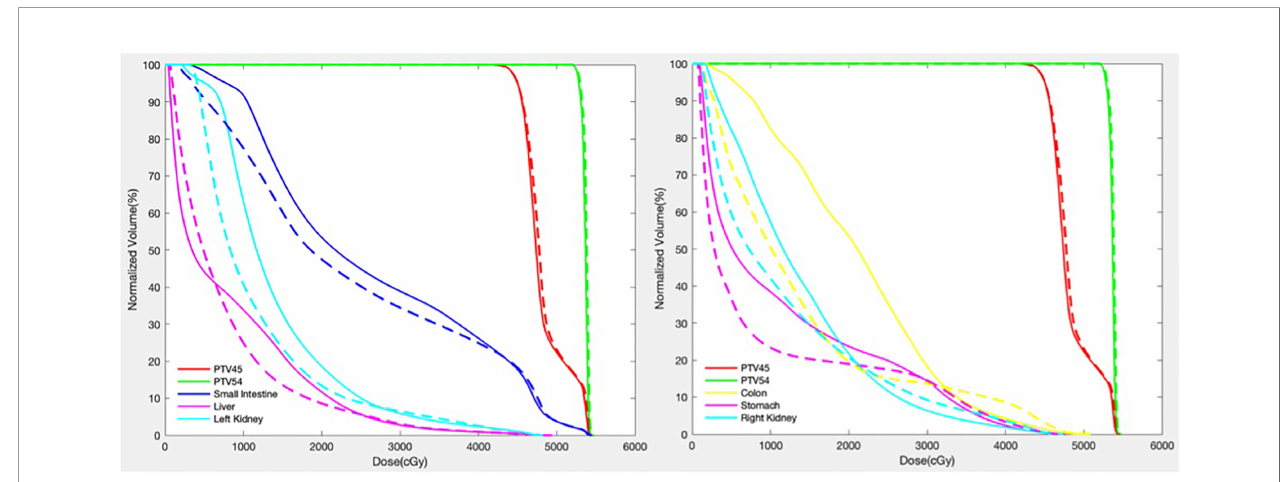
FIGURE 3 | Dose – volume histogram of PTV and selected OARs (solid line — coVMAT, dashed line —